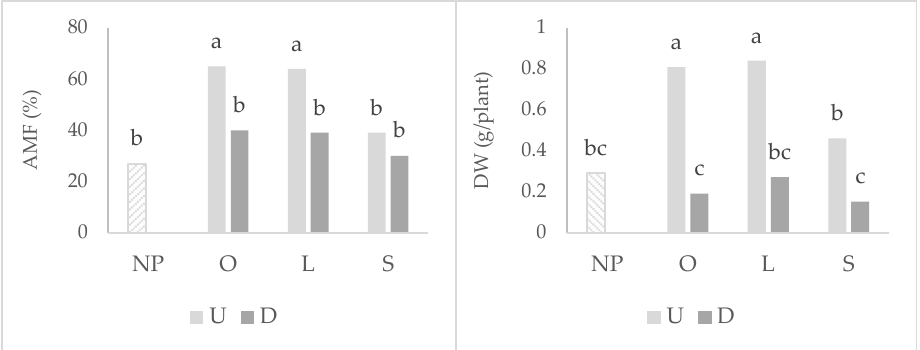
Figure 1. Graphs of interactions between previous plant type and soil disturbance in wheat root colonization by arbuscular mycorrhizal fungi (AMF) and shoot dry weight (DW). NP: wheat that grew with no previous plants; O: wheat that grew after O. compressus ; L: wheat that grew after L. rigidum ; S: wheat that grew after S. gallica ; U: soil undisturbed and D: soil disturbed. Values sharing different letters indicate significant differences between treatments at the 5% level (Tukey’s t -test).